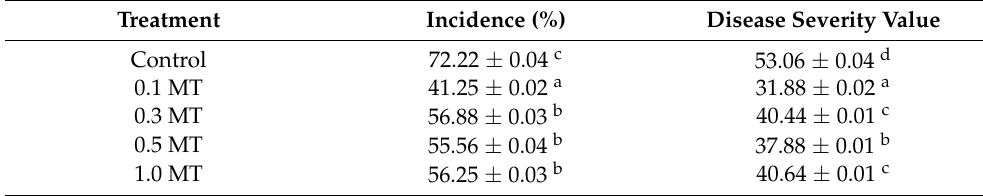
Table 2. Control efficiency of MT against soft rot of kiwifruits.